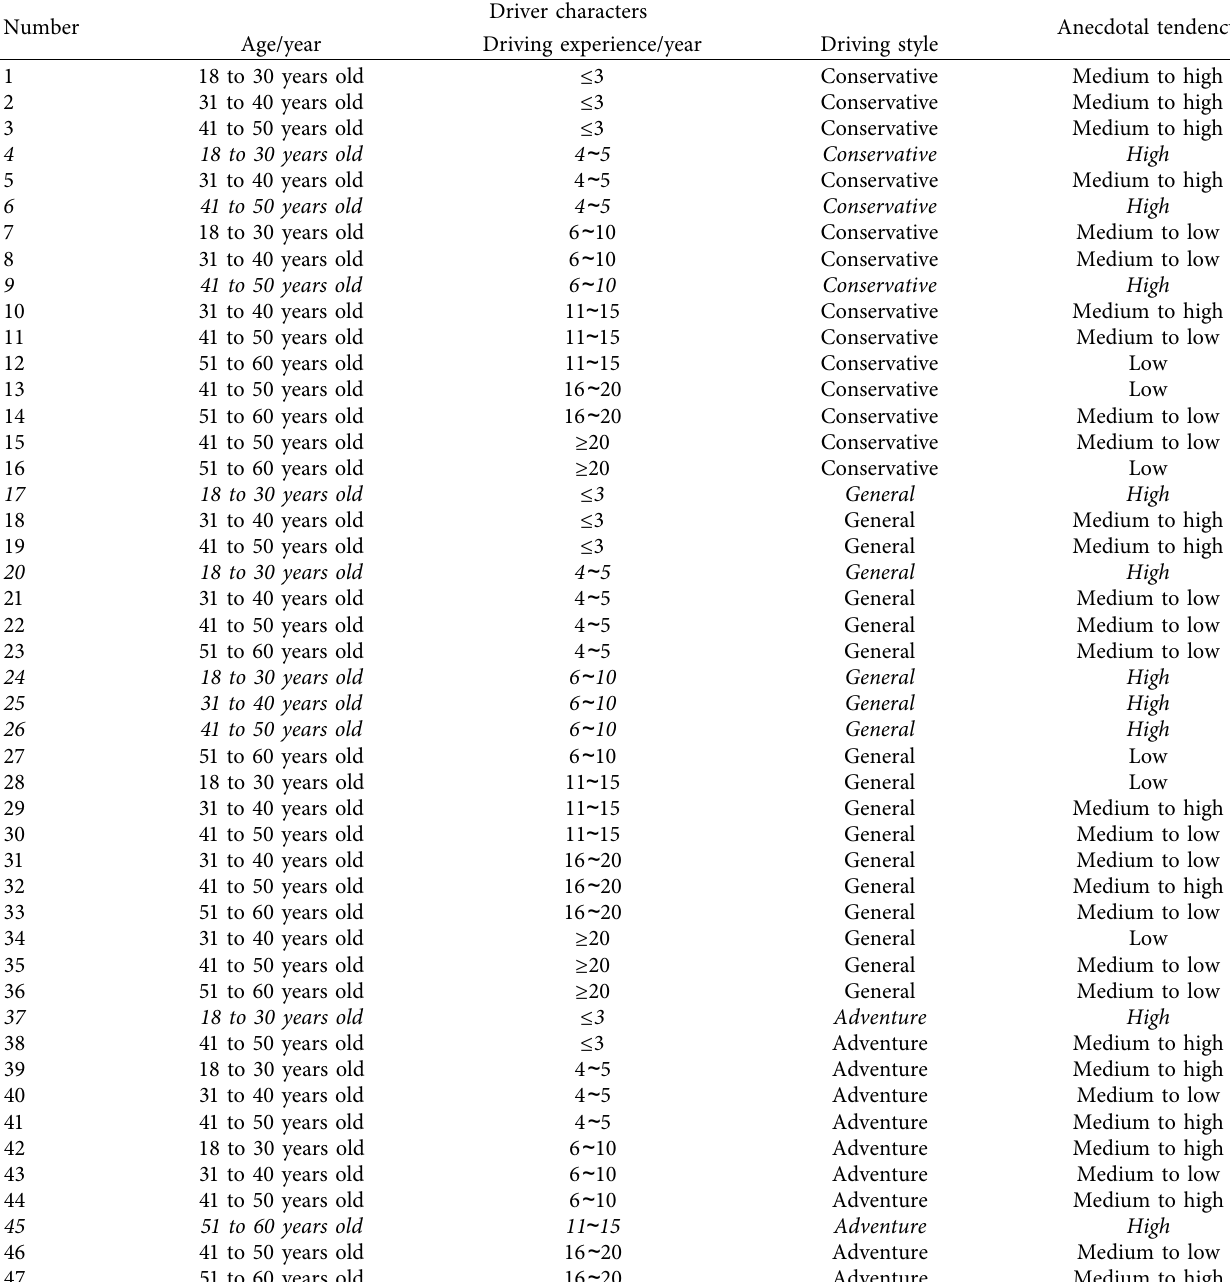
Table 2: Grey clustering calculation results of accident tendency of each group with driver